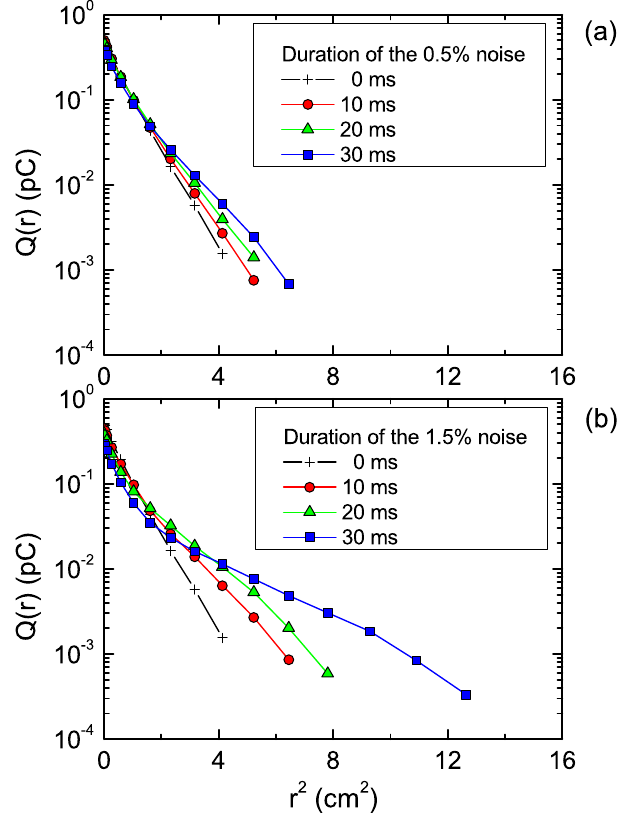
FIG. 7. (Color) Measured radial profiles with different noise amplitudes and duration. Initially, the trapped plasma is in a thermal equilibrium state, for which the radial density profile is a straight line in the log versus r 2